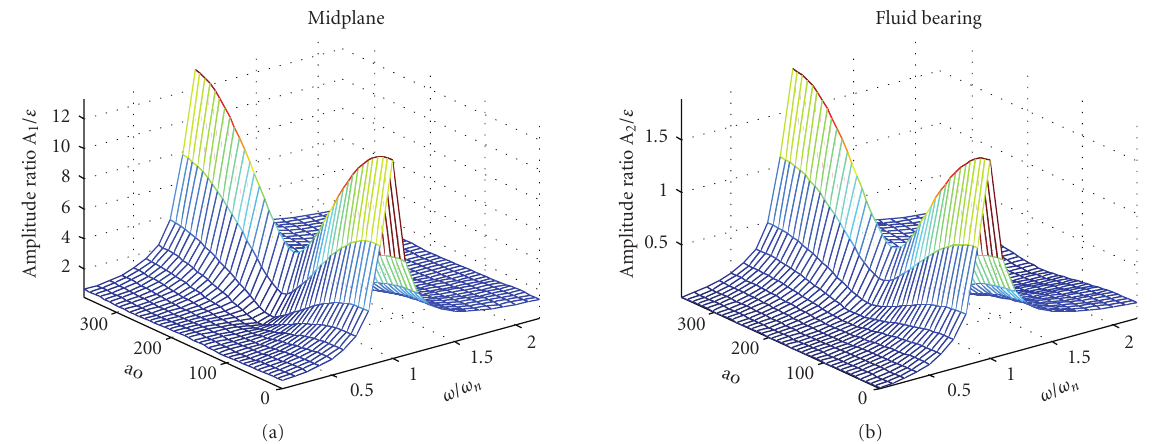
Figure 10: Response amplitude at midspan (a) and at the fluid bearing (b) for various orientations of bow with repect to imbalance. Ro = 0.5.